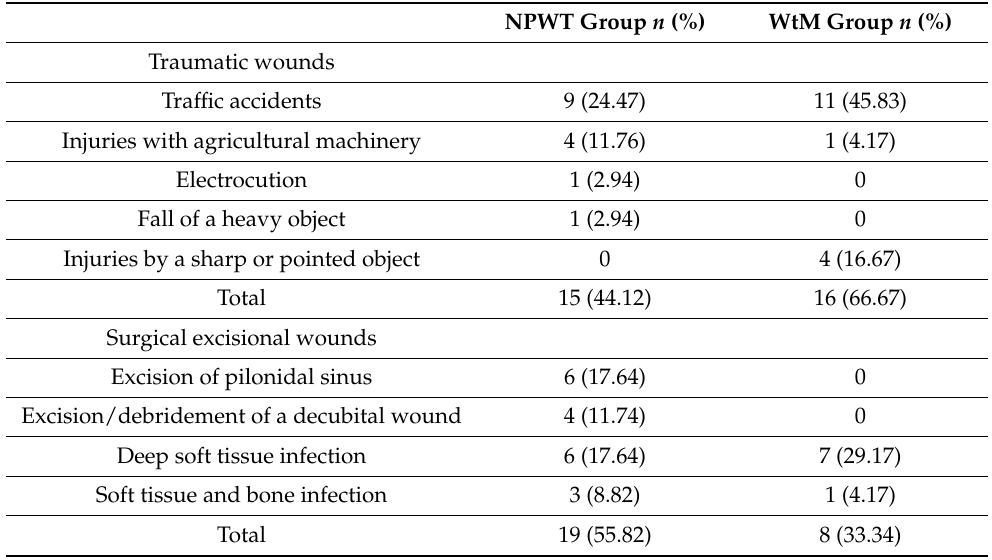
Table 2. Etiology of traumatic and surgical